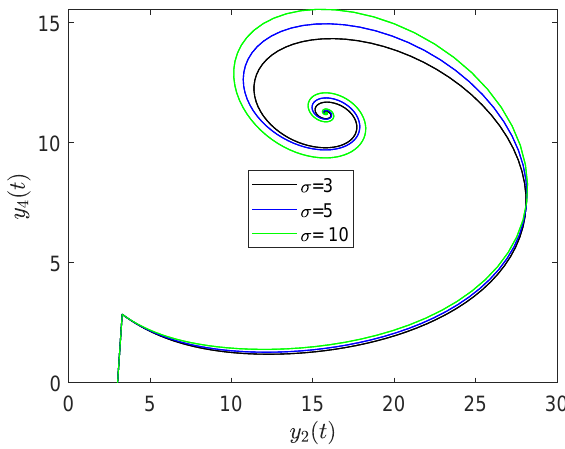
Figure 50. Phase portraits of y 2 and y 4 when varying σ .